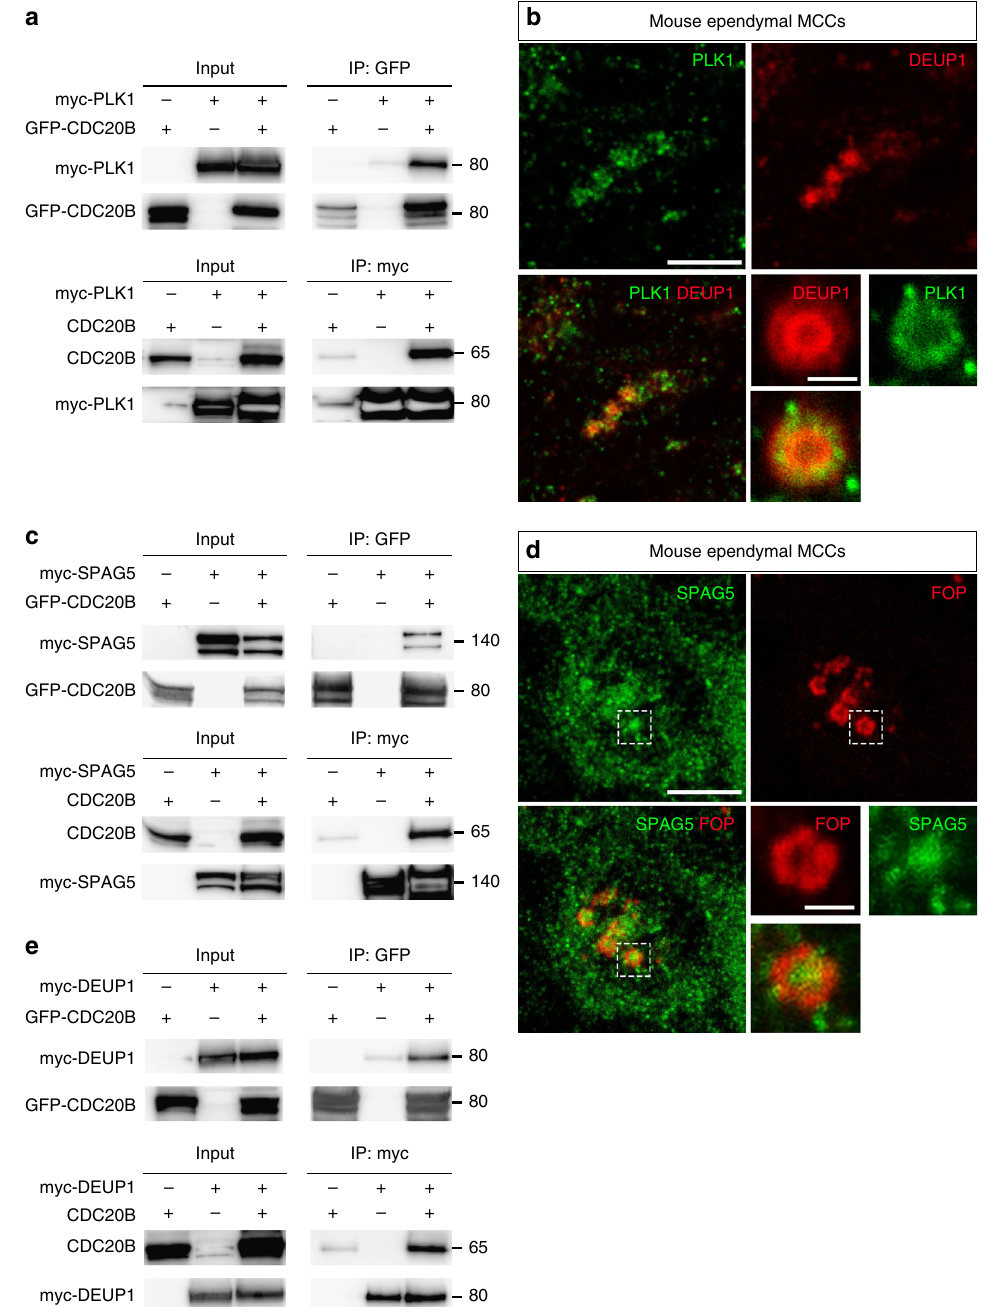
Fig. 6 CDC20B interacts with PLK1, SPAG5, and DEUP1. a , c , e Co-immunoprecipitations of PLK1, SPAG5, and DEUP1 with CDC20B were tested after transfections of different constructs in HEK cells, indicated at the top of each panel. Proteins (left legend) were revealed by immunoblotting. Representative blots from 3 independent experiments. b , d Maturing mouse ependyma were immunostained for the indicated proteins, and pictures were taken with a confocal microscope. PLK1 and SPAG5 are expressed in maturing MCCs. In b , zoom was made on a different cell to reveal PLK1 enrichment in the perideuterosomal region. In d , zoom was made on the dashed box to reveal SPAG5 enrichment in the deuterosome core. Scale bars in b , d : 5 µ m (large view), 1 µ m (high magni fi